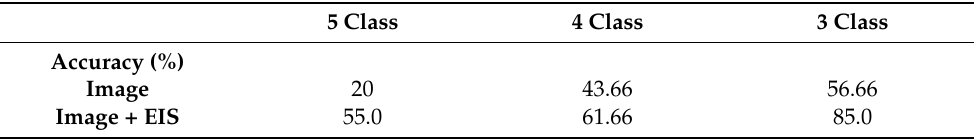
Table 4. Comparison of storage period prediction accuracy between image input only and image input with EIS information.